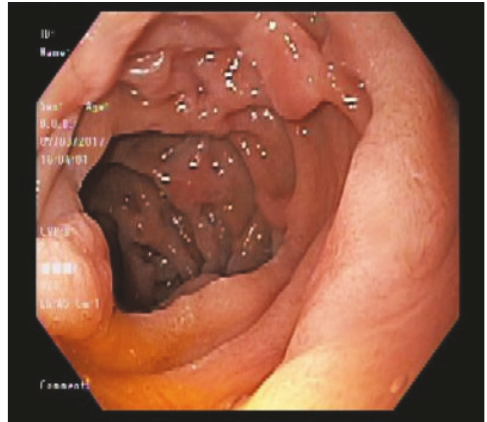
Figure 4: Nodules in the 2nd part of